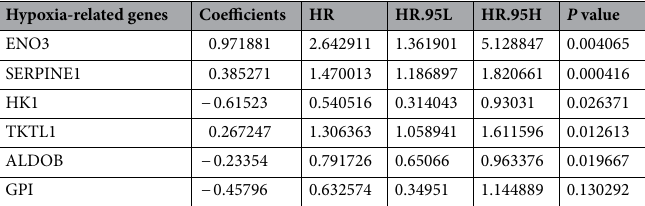
Table 1. Coefficients of hypoxia-related genes by multivariate Cox analysis.